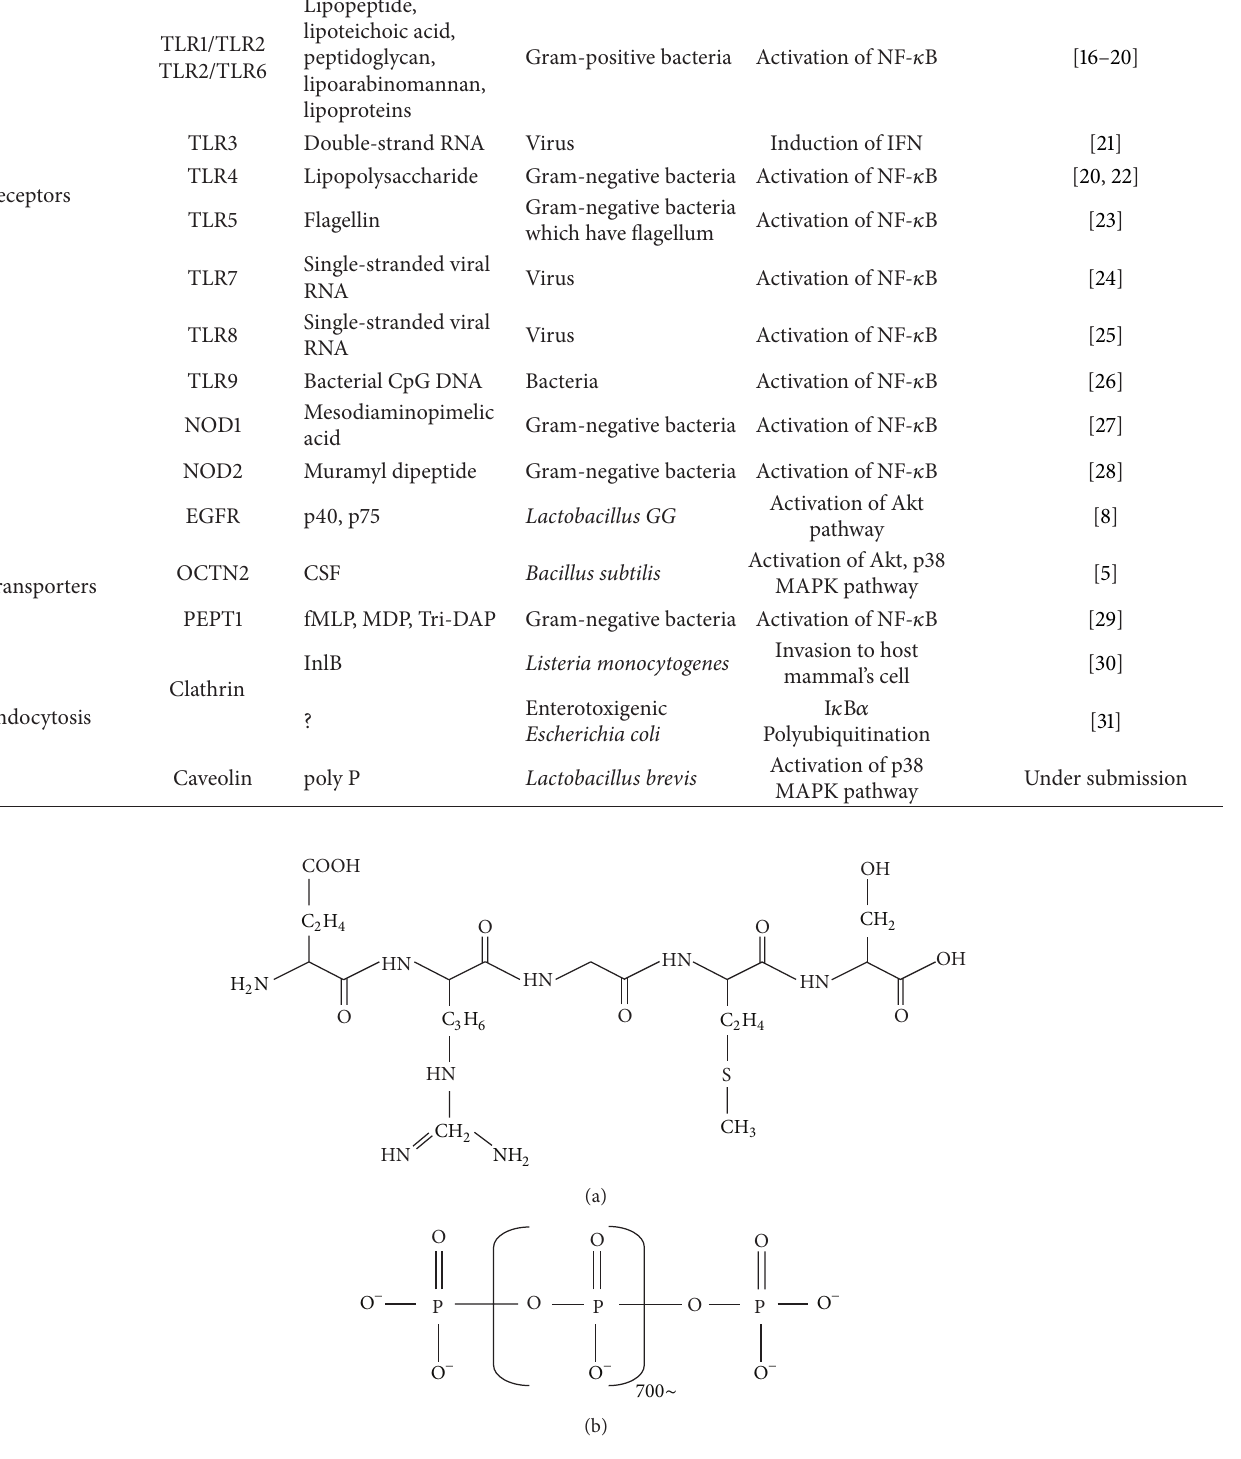
Figure 1: The structure of CSF and poly P. (a) CSF is pentapeptide, ERGMT, whose N-terminal is charged in positive. (b) poly P is long chain which consists of over 700